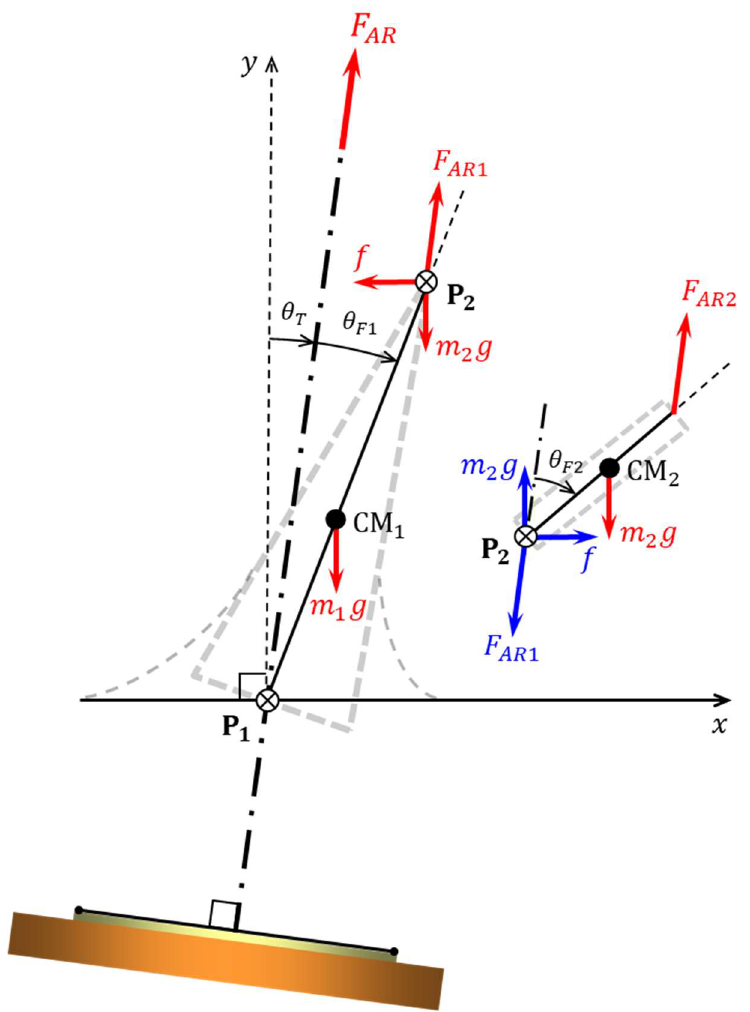
Figure A1. Forces diagram of conceptual double-compound pendulum inferred from modeled dual-part/body fountain depicted in Figure 7.